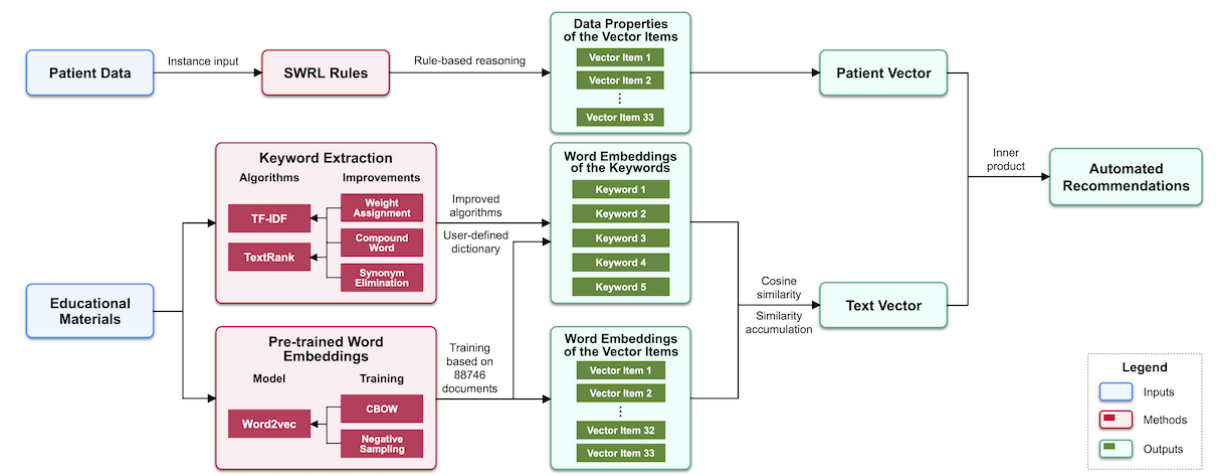
Figure 3. Recommendation generation